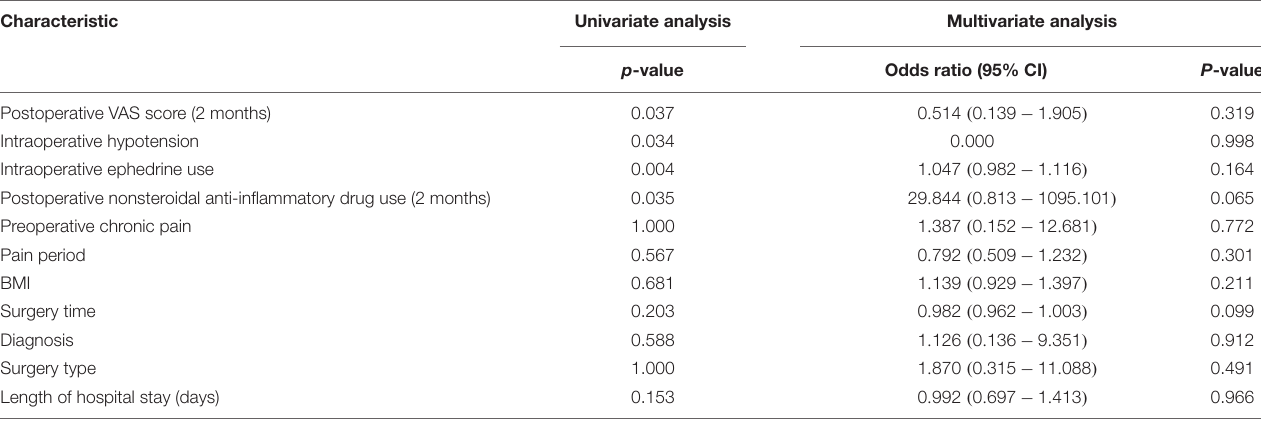
TABLE 5 | Logistic analysis for the POCD occurred at 2 months after